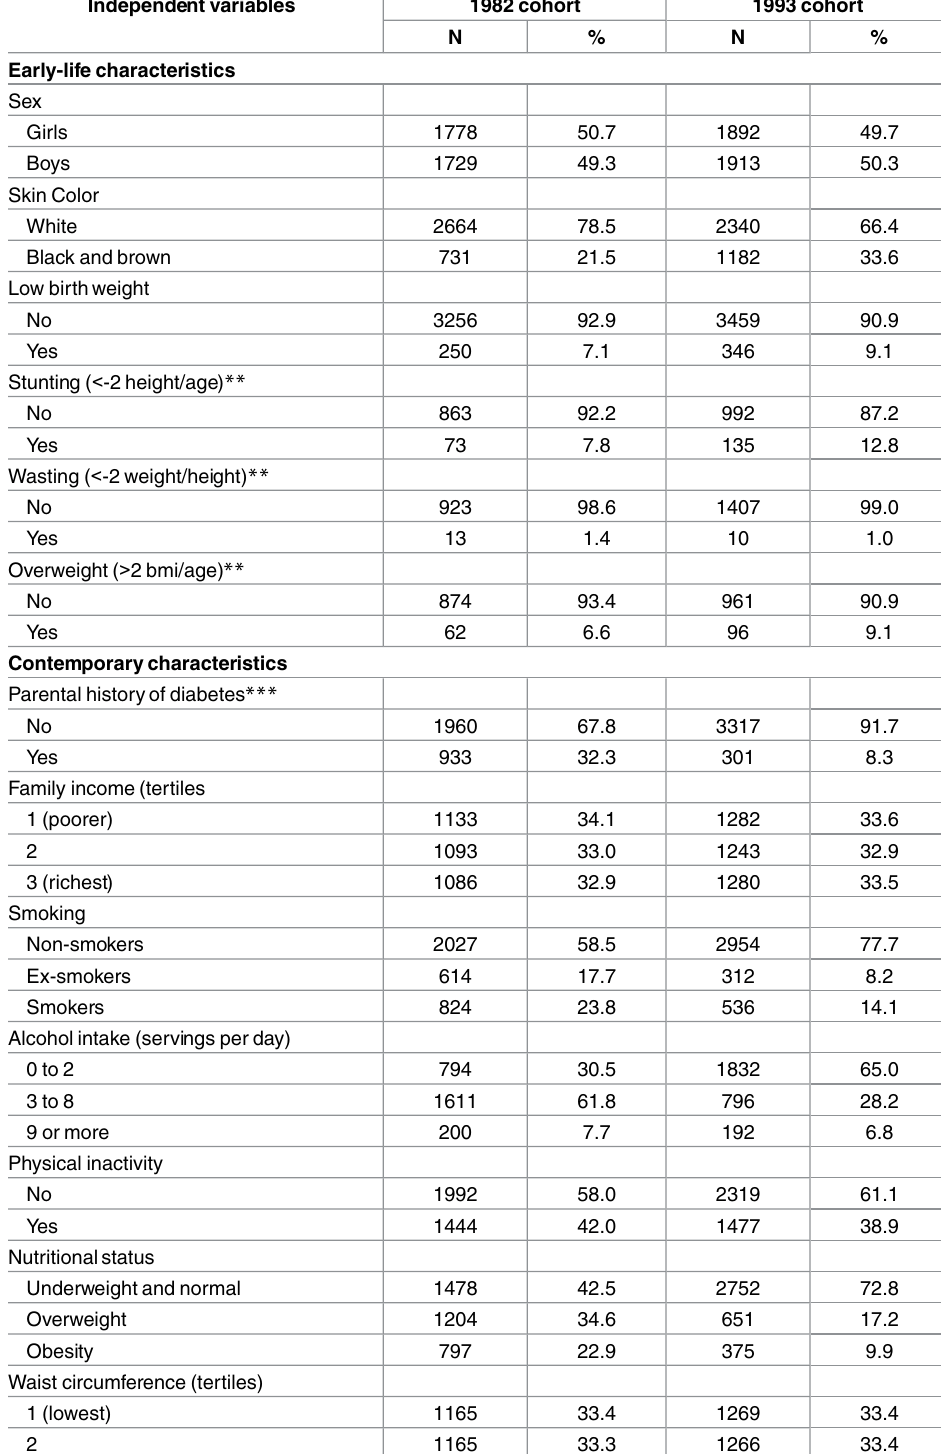
Table 1. Characteristicsof participants withinformationon normalvalues of HbA 1c * . 1982 and 1993 Pelotas